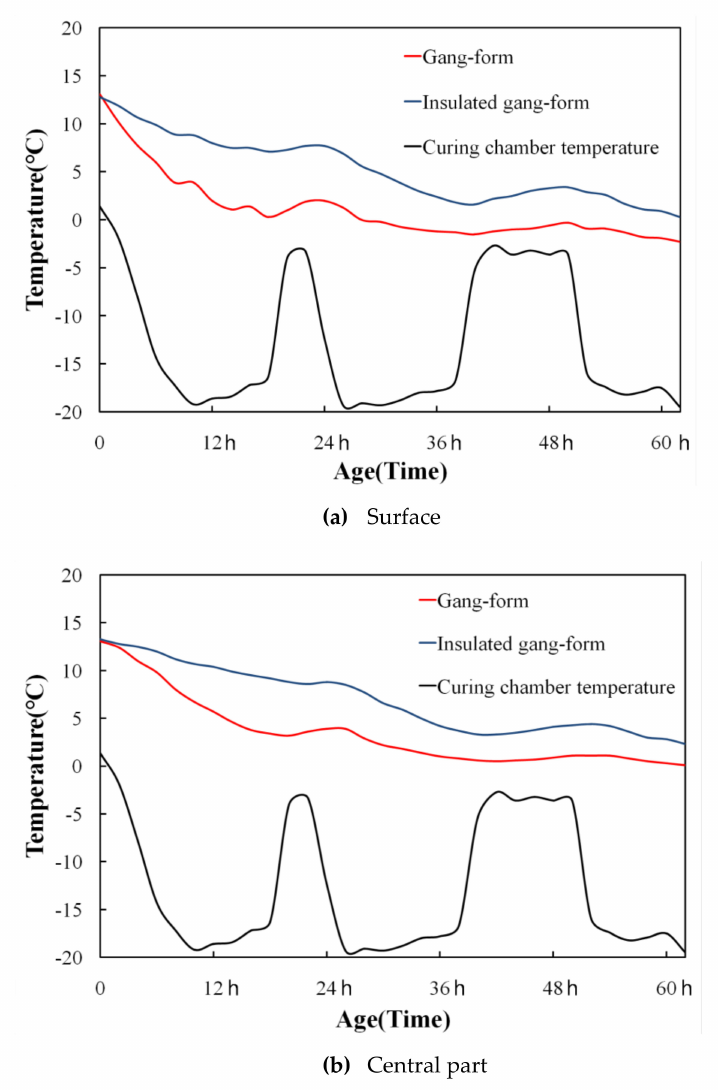
Figure 8. Temperature history of